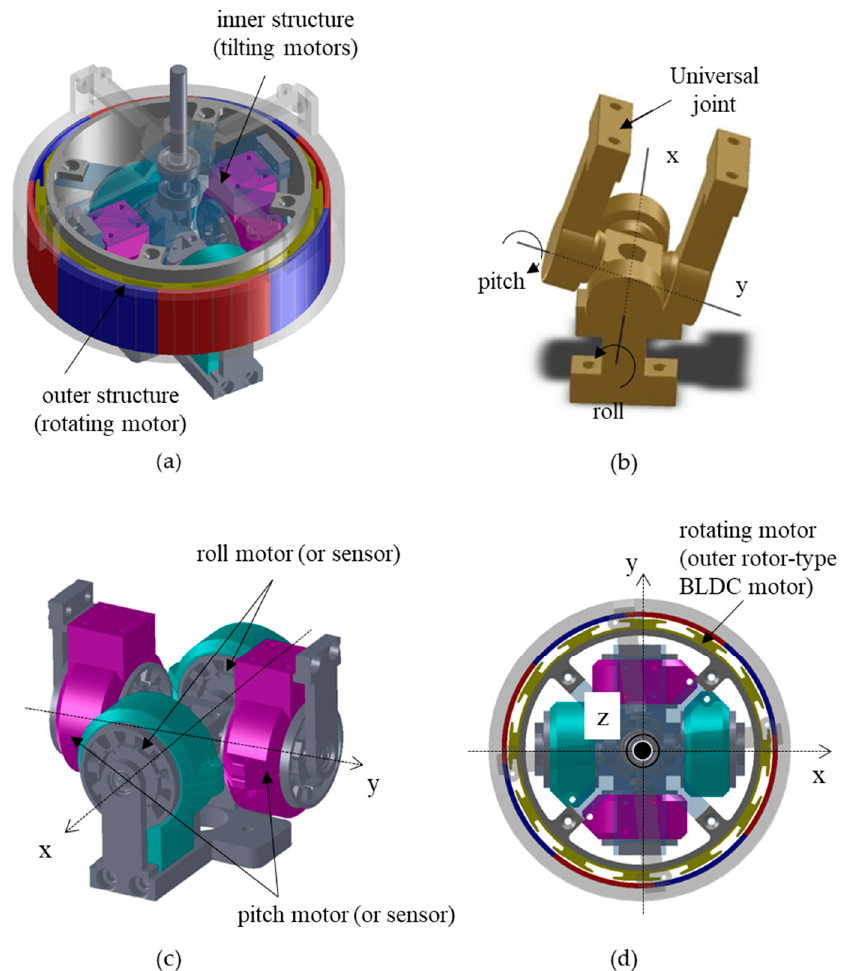
Figure 1. Structure of the HMDOF motor: ( a ) The whole structure; ( b ) The universal joint; ( c ) The inner structure; ( d ) The top view of the whole structure.